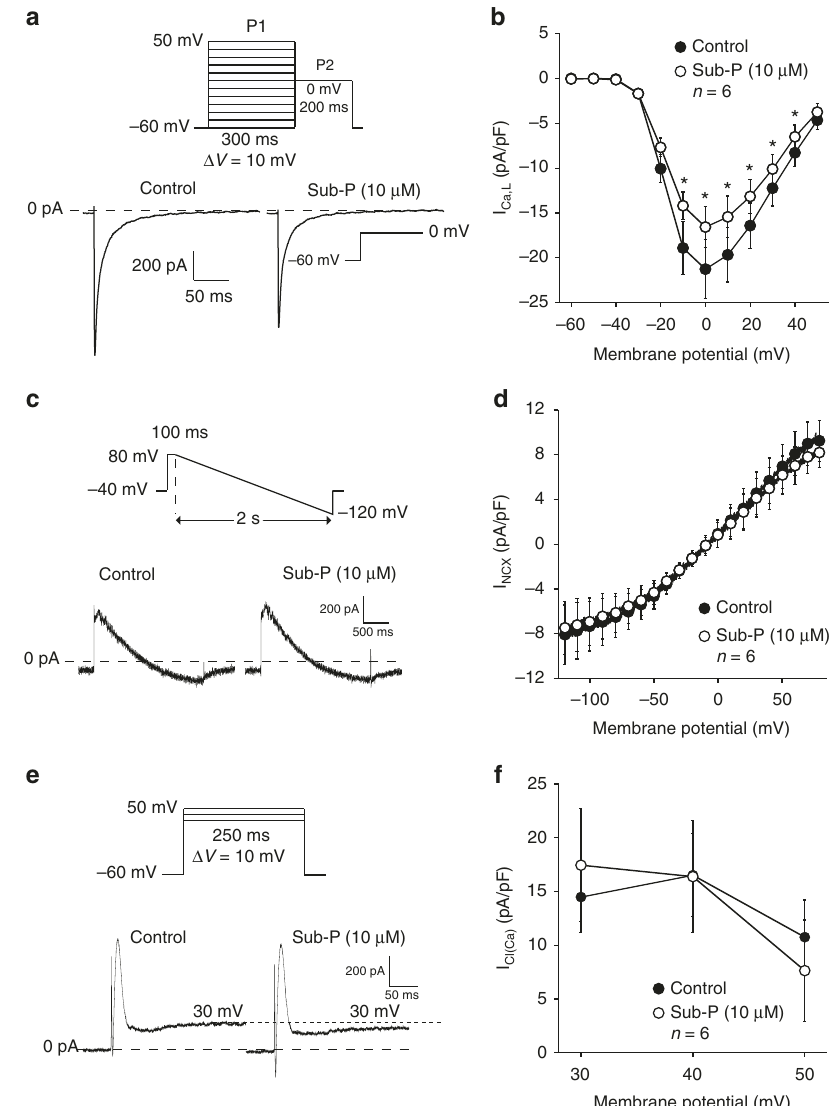
Fig. 3 Effect of substance-P on L-type Ca 2 + current and calcium-dependent currents. a Voltage protocol and I Ca,L tracings recorded at 0 mV under control conditions (Control) and in the presence of Sub-P (10 µ M). b Average current – voltage (I – V) relationships of I Ca,L during Control and after application of Sub-P (10 µ M) ( N = 3, n = 6, two-way RM ANOVA). c Voltage protocol and Na + – Ca 2 + exchange current (I NCX ) tracings recorded in Control and in the presence of Sub-P (10 µ M). d Average I – V relationships of I NCX before (Control) and after application of Sub-P (10 µ M) ( N = 2, n = 6, two-way RM ANOVA). e Voltage protocol and Ca 2 + activated Cl − current (I Ca(Cl) ) recordings at + 30 mV in Control and in the presence of Sub-P (10 µ M). f Average I – V relationships of peak I Ca(Cl) before (Control) and after application of Sub-P (10 µ M) ( N = 2, n = 6, two-way RM ANOVA). Blockers for Na + -, transient outward and ultra-rapid delayed recti fi er K + currents were continuously present. All values shown are mean ± SEM. * P <